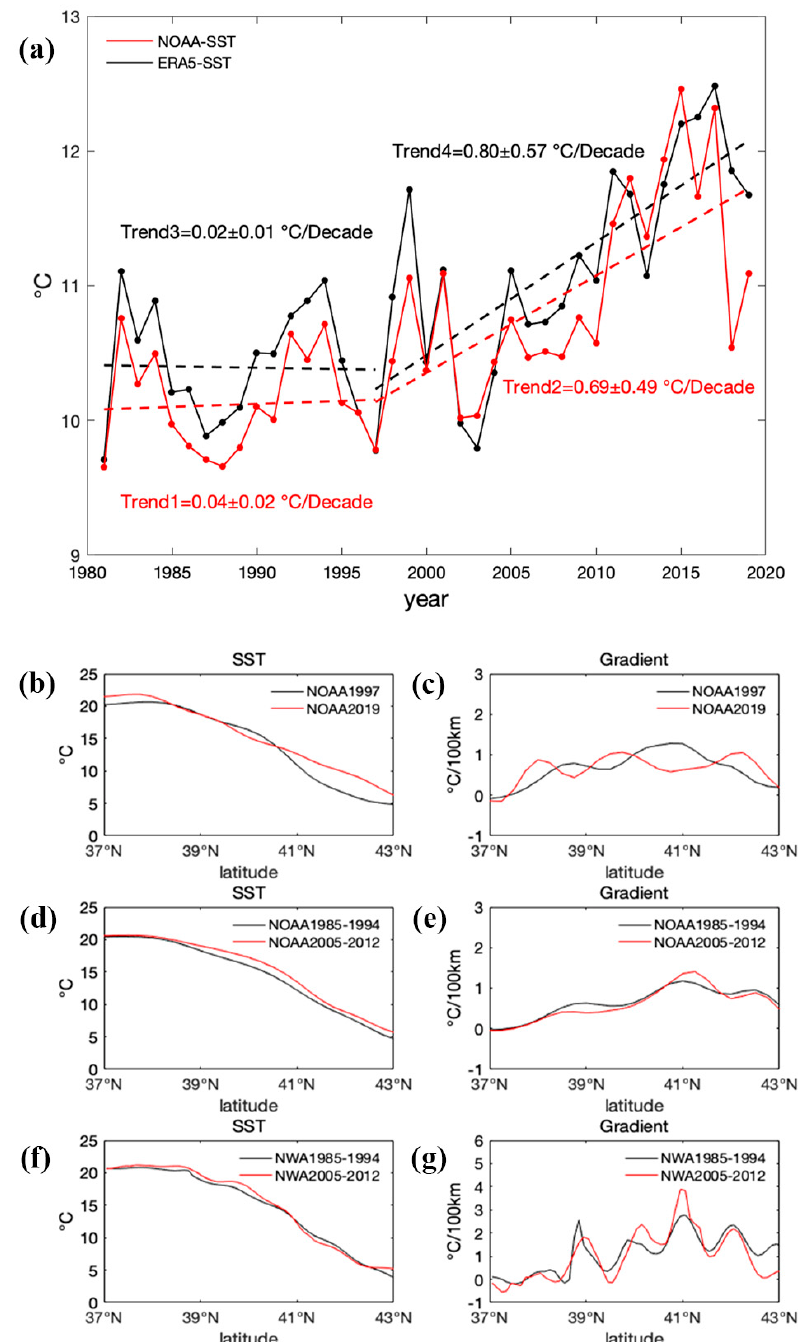
Figure 2. ( a ) Time series of SST (solid line) averaged in the region (35 °N–45 °N, 72 °W ‒ 56 °W) from 1981 to 2019 (°C), with linear trend lines from a regression (dashed line). Red is for NOAA OISST and black is for ERA5-SST. The values of the trend (± one standard error) are annotated. The linear trend of 1997 ‒ 2019 arise significant at the 95% confidence level (Trend 2 and Trend 4). Trends before 1997 (Trend 1 and Trend 3) did not pass the significance test. ( b ) SST profile along 64 °W in 1997 (black) and 2019 (red) from NOAA OISST (°C). ( c ) As in ( b ) but for SST gradient (°C / 100 km). ( d ) SST profile along 64 °W averaged in 1985 ‒ 1994 (black) and 2005 ‒ 2012 (red) from NOAA OISST (°C). ( e ) As in ( d ) but for SST gradient (°C / 100 km). ( f ) SST profile along 64 °W averaged in 1985 ‒ 1994 (black) and 2005 ‒ 2012 (red) from the NWARC dataset (°C). ( g ) As in ( f ) but for SST gradient (°C / 100 km).